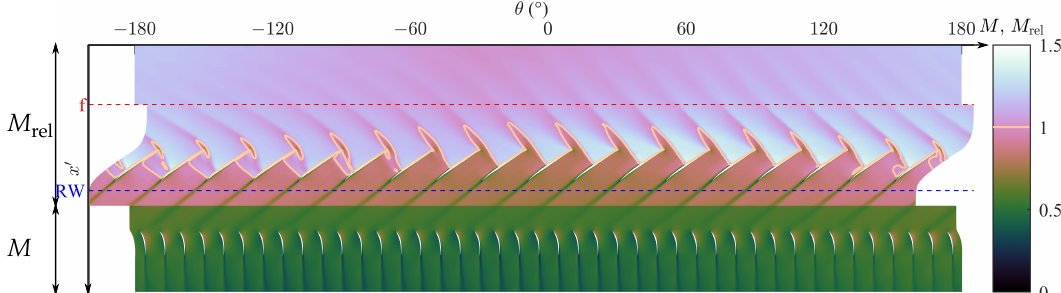
Figure 16. Instantaneous propulsor blade-to-blade variations of Mach number in the local reference frame near tip, 90% rotor span, for case I. The Mach 1 line is in